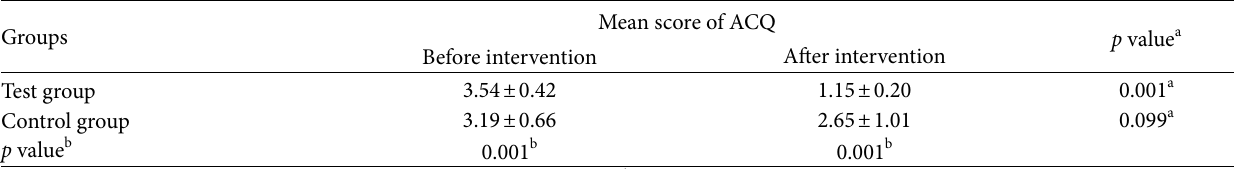
n indicates the number of patients. Table 4: Level of asthma control of asthmatic patients before and after intervention.